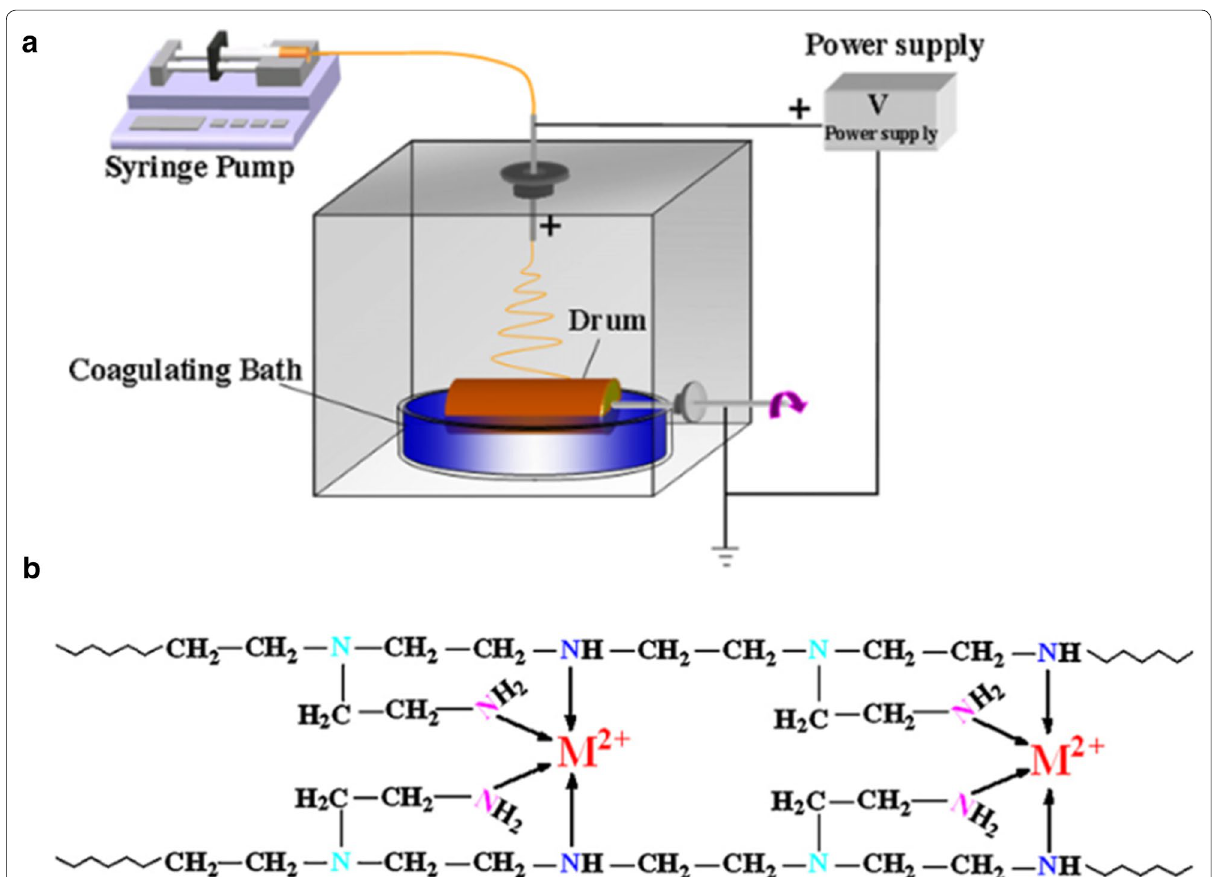
Fig. 9 a Scheme of a wet-electrospinning process and b removal mechanism of heavy metal ions (M 2 + ) using N atoms in PEI polymer